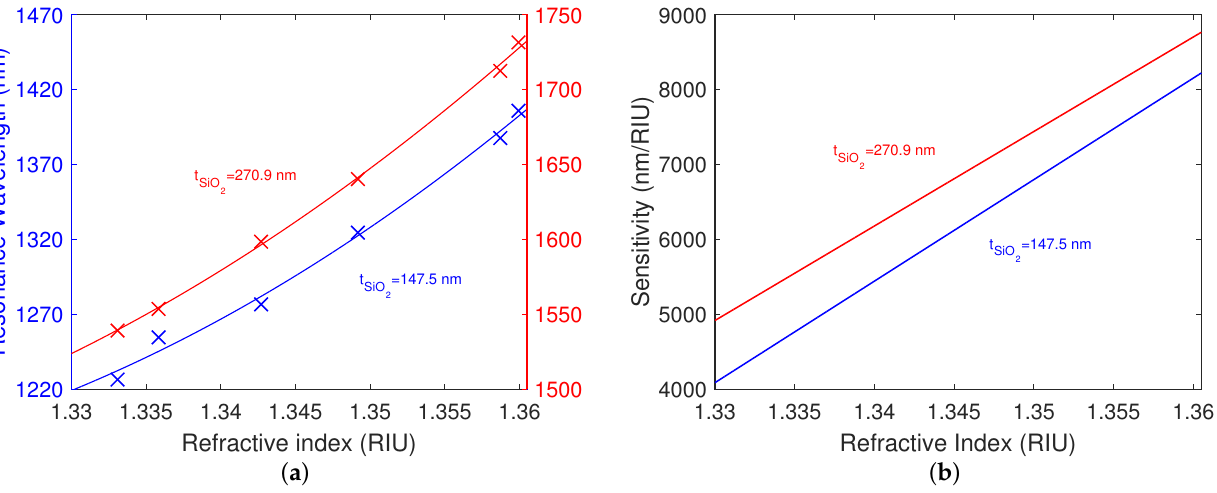
Figure 10. Measured resonance wavelength as a function of refractive index of the analyte and second-order polynomial fit for both structures ( a ). RI sensitivity measured for both structures ( b ). The angle of incidence θ ≈ 70.2 ◦